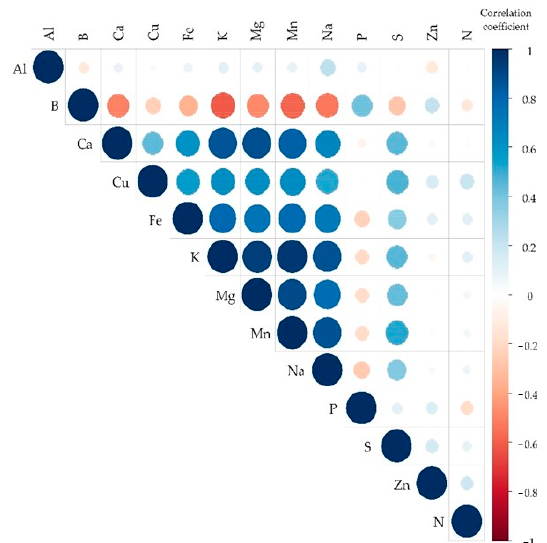
Figure A1. Color correlation graph between element content in plum samples.